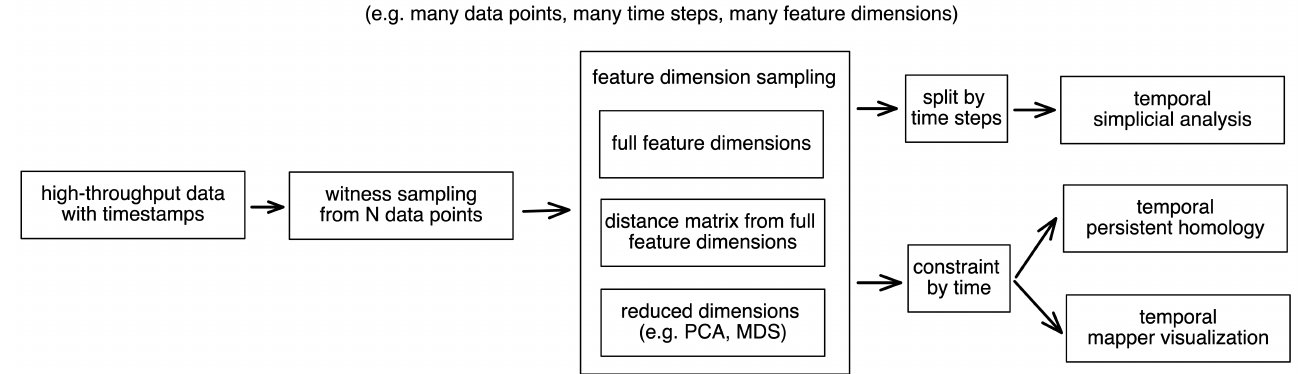
Figure 4. Pipeline of the time series topological data analysis for high-throughput data. We started with the high-throughput data points marked with their timestamps. To decrease the number of data points for efficient computation (and also comparability across time points), witness sampling was performed among these data points. Then, one could choose to reduce the dimension or not given the noise and distribution properties of their data. To perform the temporal simplicial analysis, the data points were first separately grouped into different time points. Then, we computed their filtrations to obtain their number of simplicial complexes at different orders. To perform the temporal persistent homology and mapper visualization, one could apply the temporal constraint onto the data points sampled so far to obtain a temporal